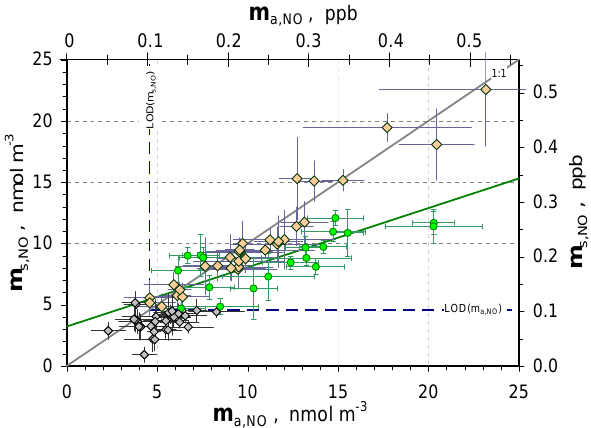
Fig. 15. Field measurements: NO concentration measured at the Figure 15. Field measurements: NO concentration measured at the outlet of the dynamic 2 outlet of the dynamic plant chamber ( m s , NO ) vs. NO concen- plant chamber ( m s,NO ) vs. NO concentration measured at the inlet of the dynamic plant 3 tration measured at the inlet of the dynamic plant chamber chamber ( m a,NO ). Light green circles identify data pairs for significance of  m NO= = 4 ( m a,NO ). Light green circles identify data pairs for significance of ( m a,NO  m s,NO ), reddish diamonds stand for those data pairs, which have to be rejected for 5 1m NO =( m a,NO − m s,NO ), reddish diamonds stand for those data non-significance of  m O3 and grey diamonds for data pairs where m NO ≤ LOD ( m NO ) . Green 6 pairs, which have to be rejected for non-significance of 1m O line (considering green circle data) is calculated according to bi-variate weighted linear least-7 grey diamonds for data pairs where m NO ≤ LOD( m NO ). Green squares fitting regression analysis (see Sect. 3.4.6). 8 line (considering green circle data) is calculated according to bi- variate weighted linear least-squares fitting regression analysis (see Sect.